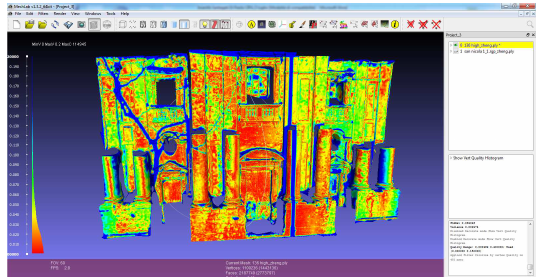
Figure 12: San Nicola façade mesh alignment error evaluation histogram: red (good) blue